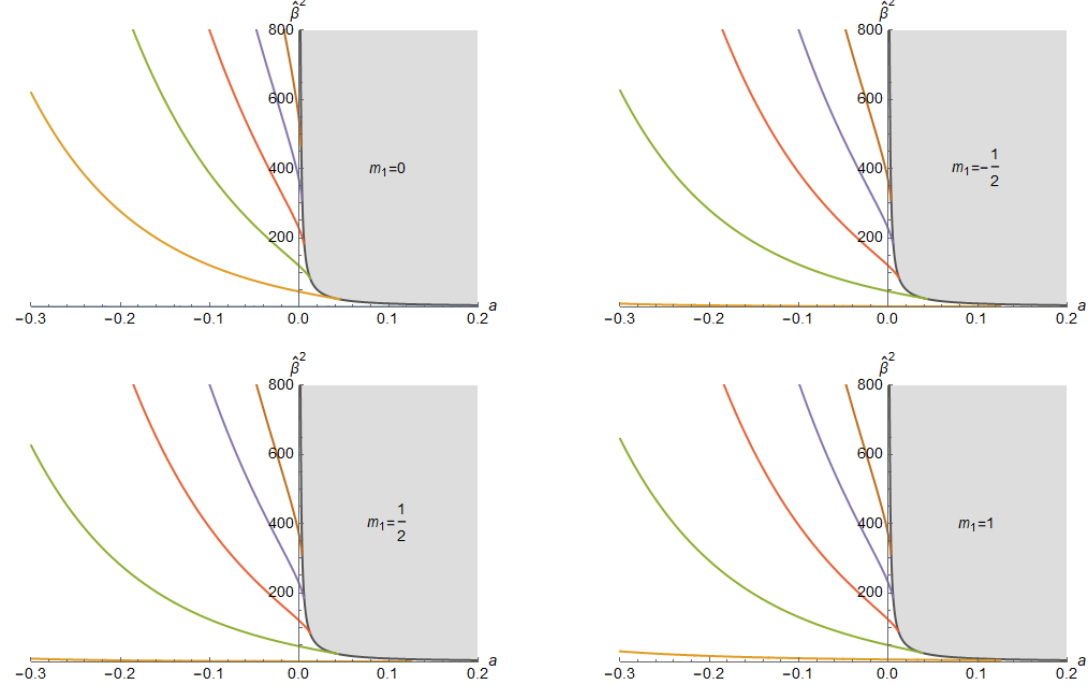
ˆ = 0 , − 1 / 2 , 1 / 2 , 1 (as Figure 1 . Spectrum of the first five eigenvalues β 2 of equation (5.59) for m R 1 labelled). The case m R = 0 contains an additional line at ˆ β 2 = 0 representing the BPS families 1 of spin-two states in the backgrounds of section 3 labelled by ‘ . The remaining curves represent 1 non-BPS families with ‘ = 0 and any ‘ 2 m R . The parameter a interpolates between the O5-O5 2 1 ≥ 1 ˆ configuration ( a = − ˆ b 2 ≤ 0 ) and the D5-O5 one ( a = b 2 > 0 ). The O5-O5 configuration shows an 1 1 unbounded discrete spectrum. For the D5-O5 case the discrete spectrum is bounded from above by a cut separating the continuum of unnormalizable solutions (shaded